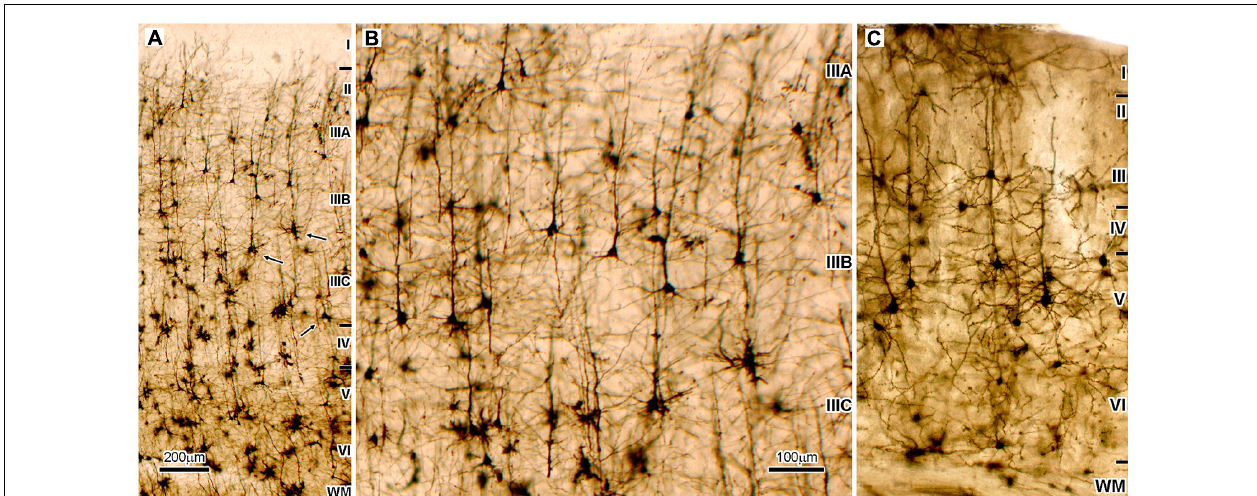
ramified axon tree (Morrison and Hof, 2002). The mentioned morphological features are a mark of associative cortico-cortical neurons. (B) Enlarged part of panel (A) is shown to be of the same magnification as panel (C) . (C) The highest order associative areas in the mice neocortex are located in the parieto-occipital region. When compared to highest order associative areas of the human neocortex (A,B) proportion of cortico-cortical projecting neurons is smaller than cortico-subcortical projecting neurons, and the largest neurons are layer V pyramids. Therefore, thickness of layers II/III in mice is less than half of the thickness of layers V/VI, which is opposite to human. In the parasensory associative areas (that do not have developed sublayer IIIC) of the human temporal cortex, layers II/III contain 44% of total number of neurons and have 30% more neurons than are located in layers V/VI (DeFelipe, 2011). It can be assumed that in areas with developed layer IIIC upper cortical layers contain more than 50% of neurons. In mice, upper cortical layers contain only 22% of neurons that is less than half of amount located in layers